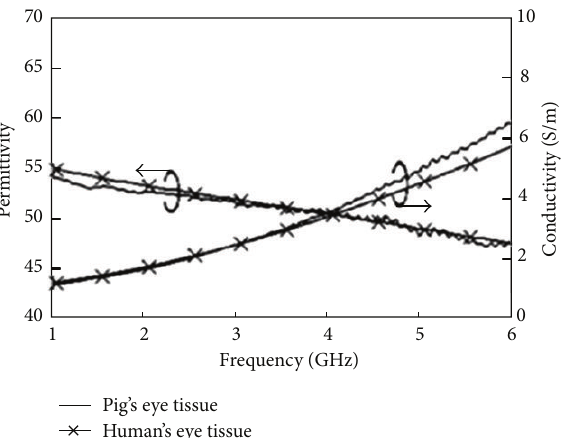
Figure 3: Comparing the permittivity and conductivity against frequency of the test tissue (pig’s eye) and the reference tissue (human’s eye).